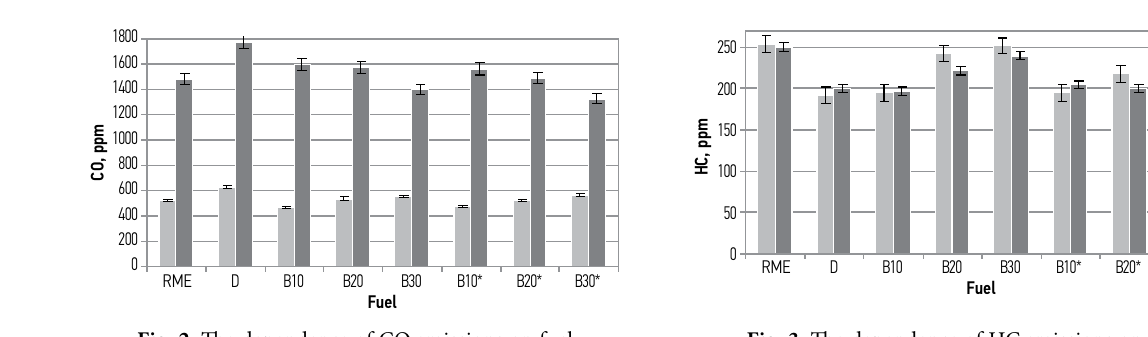
Fig. 2 . The dependence of CO emissions on fuel composition at the engine rotation speeds of: